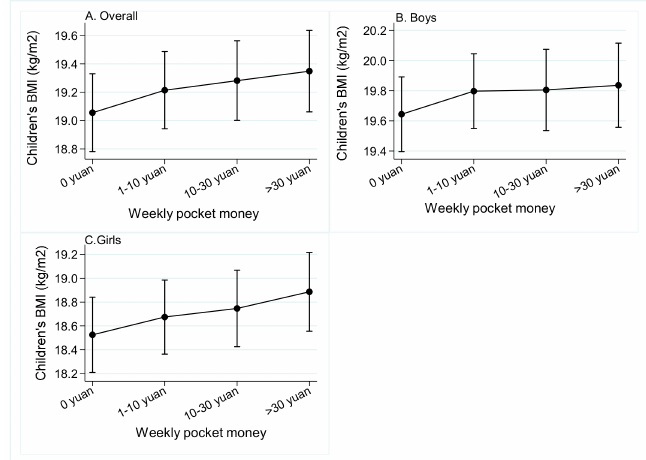
Figure 1. Adjusted mean of children’s BMI for each level of weekly pocket money when covariates are at their mean after mixed-e ff ects linear regression model: The Childhood Obesity Study in China Mega-Cities. Mixed-e ff ects model was fit to examine the longitudinal association between children’s BMI and weekly pocket money, adjusting for time, gender, age, paternal BMI, maternal BMI, paternal education, maternal education, and family homeownership. The mixed-e ff ects model was fit for all children, boys, and girls, respectively. Location was included in the models as a random e ff ect (intercept). The marginal means of children’s BMI was estimated based on pocket money in the mixed-e ff ect model conditioned the other covariates was on average. As weekly pocket money changed in four categories (0, 1–10, 11–30, > 30 yuan), the predicted mean of BMI was 19.0, 19.2, 19.3, 19.4 kg / m 2 for all children, the BMI was 19.6, 19.8, 19.8, 19.8 kg / m 2 for boys, 18.5, 18.7, 18.7, 18.9 kg / m 2 for girls. Only children who participated in ≥ two surveys in the 2015, 2016, and 2017 surveys were included in this analysis ( n =